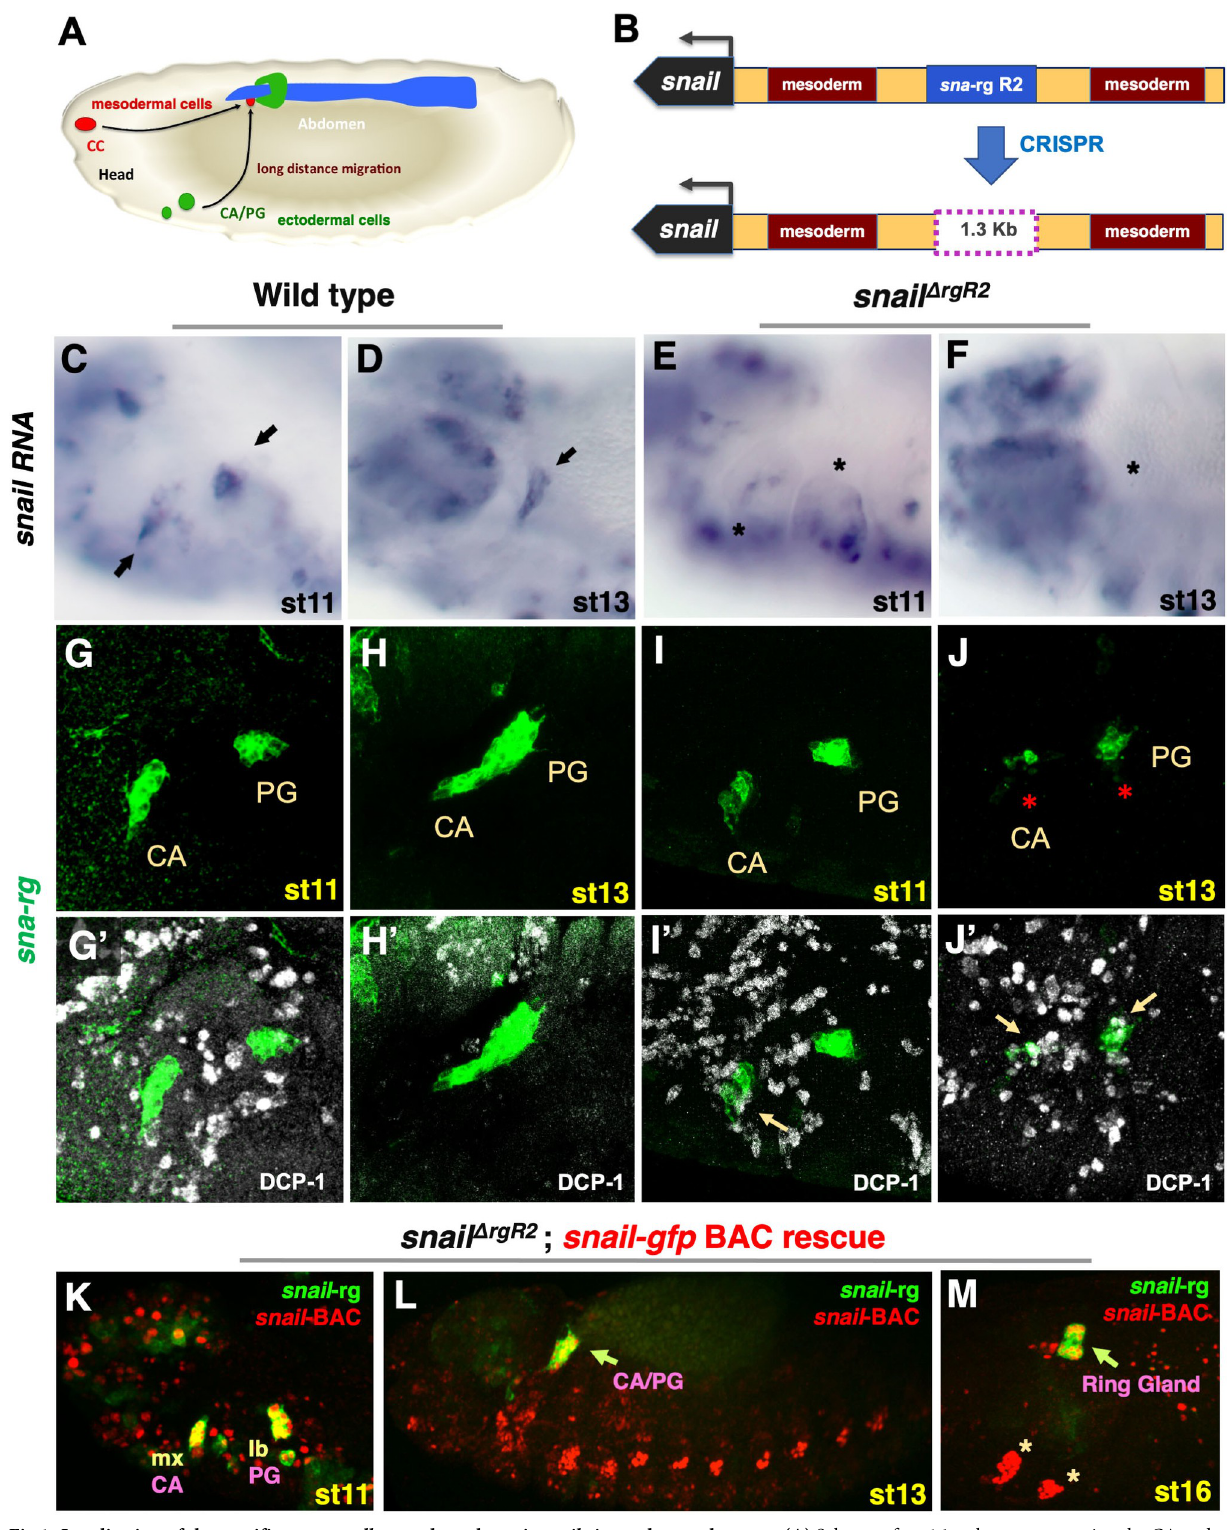
Fig 1. Localisation of the specific corpora allata and prothoracic snail cis regulatory elements. (A) Scheme of a st16 embryo representing the CA and PG in green, the corpora cardiaca (CC) in red and the aorta and heart in blue. The migratory route followed by the three gland primordia towards